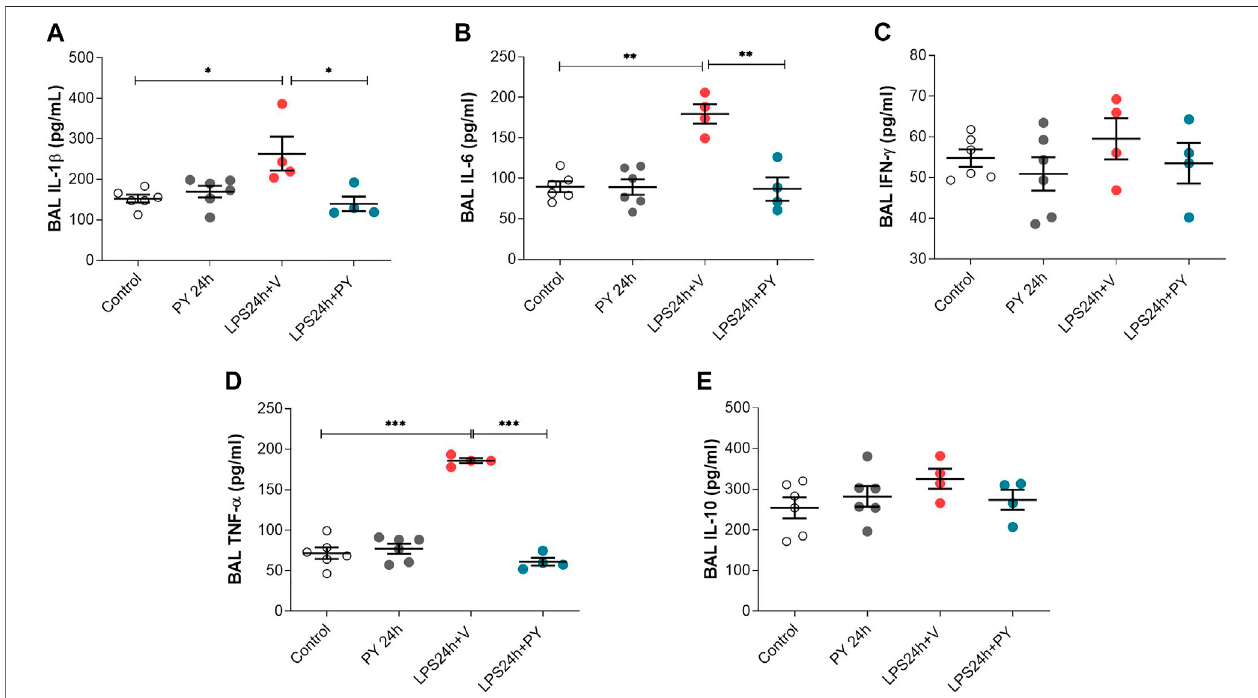
FIGURE 5 | Physostigmine decreases pro-in fl ammatory cytokine levels in BAL at 24 h. (A) IL-1 β , (B) IL-6, (C) IFN- γ , (D) TNF- α , (E) IL-10. *** p < 0.001, ** p < 0.01 and * p < 0.05. Vehicle (V) group (Control), pyiridostigmine (PY), lipopolysaccharide (LPS). Values expressed as mean ± SEM. One-way ANOVA followed by Tukey ’ s test (See text for details).